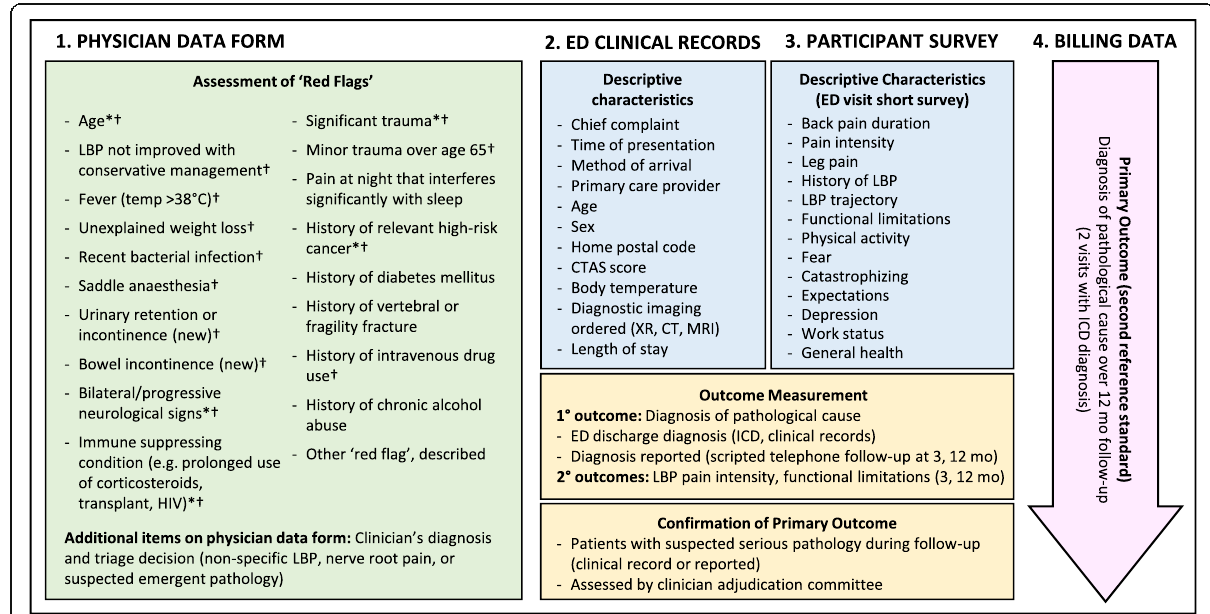
Fig. 1 Baseline variables, including red flags and descriptive characteristics, and outcome variables of four data sources. The asterisk indicates the red flag with evidence of positive likelihood ratio >5.0; the dagger represents the red flag described in the American College of Physicians low back pain clinical practice guideline [9] or by the American College of Radiology [8]; LBP, low back pain; CTAS, Canadian Triage and Acuity Score; ICD, International Classification of Disease; XR, plain-film X-ray; CT, computed tomography; MRI, magnetic resonance imaging; ED, emergency